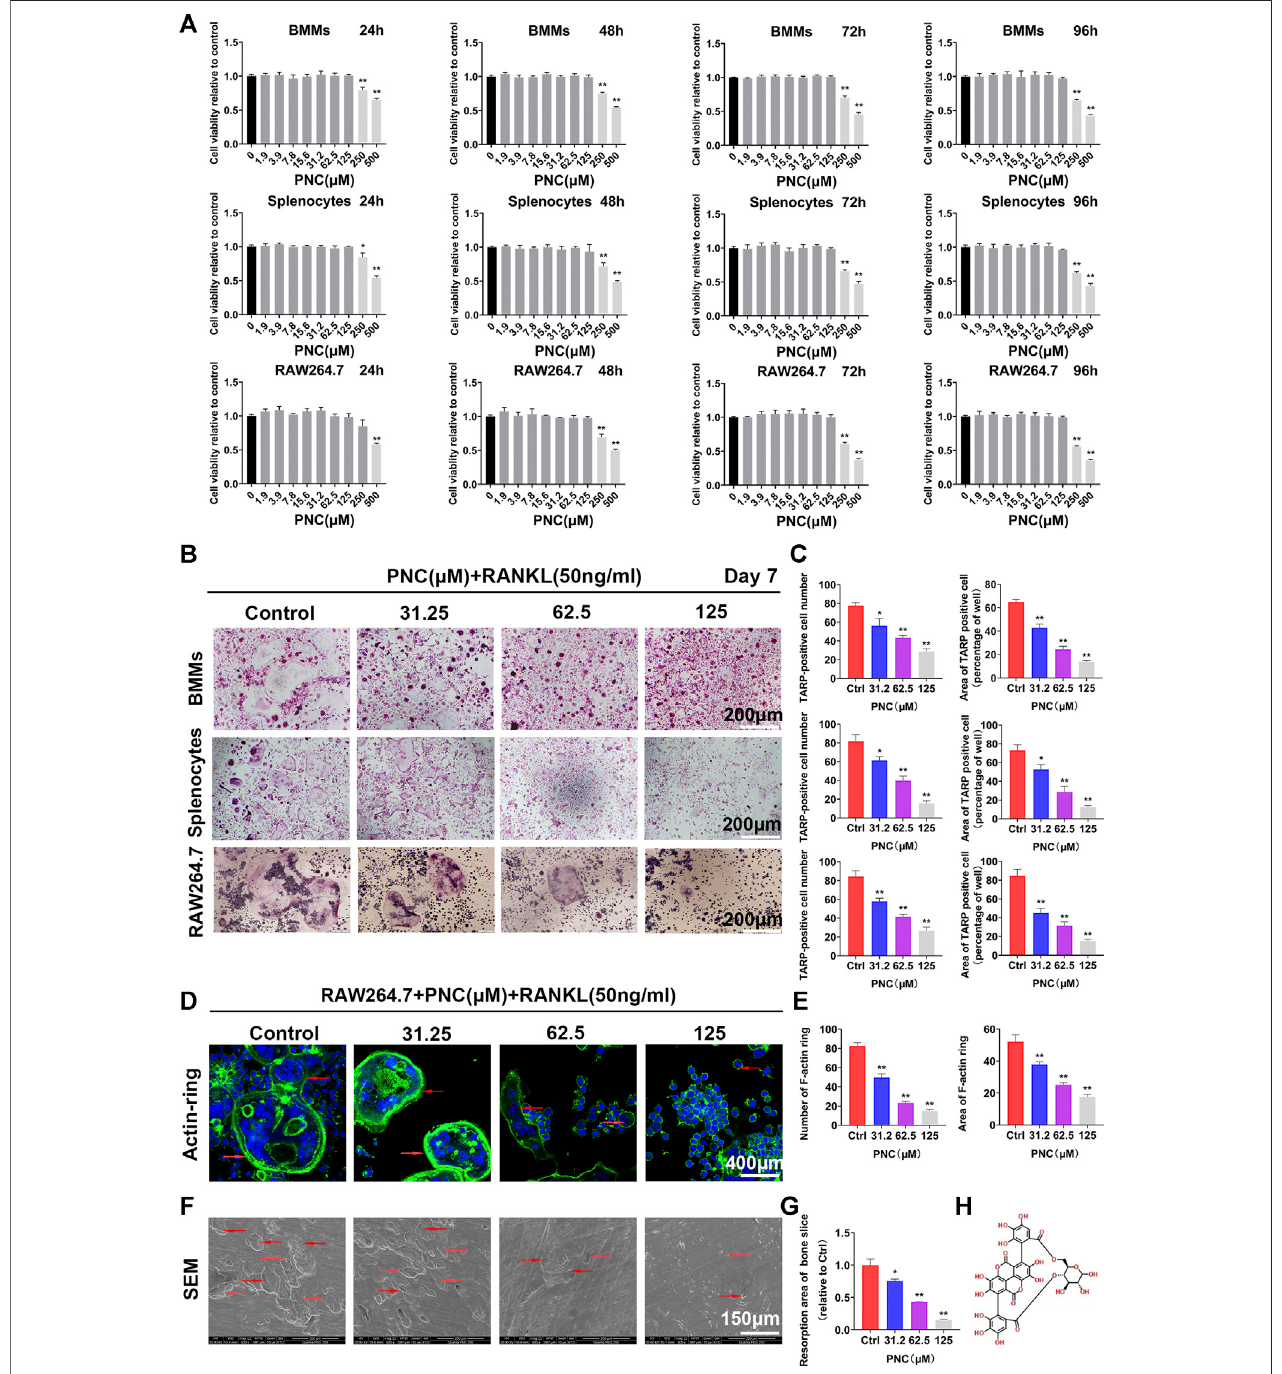
FIGURE1| Nontoxic punicalin (PNC) inhibitedRANKL-mediated osteoclast differentiation aswell asfunction in vitro . (A) Cell viabilities ofpreosteoclasts after PNC treatments from 24 to 96 h ( n (cid:1) 3). (B) Osteoclastogenesis of three kinds of preosteoclasts, BMMs, splenocytes and RAW 264.7 cells in vitro after RANKL and PNC administration. (C) Quanti fi cation of osteoclast formation by PNC ( n (cid:1) 3). (D) F-actin ring formation after RANKL and PNC treatment. DAPI indicated cell nuclei (the red arrows indicate the F-actin ring). (E) Quantitative analysis of F-actin rings and osteoclast formation ( n (cid:1) 3). (F) Bone resorption pit formation after RANKL as well as PNC administration (the red arrows mark bone resorption pits). (G) Quantitative analyses of bone resorption pits ( n (cid:1) 3). (H) Structural formula of PNC. ** p < 0.05, ** p < 0.01 compared to controls.